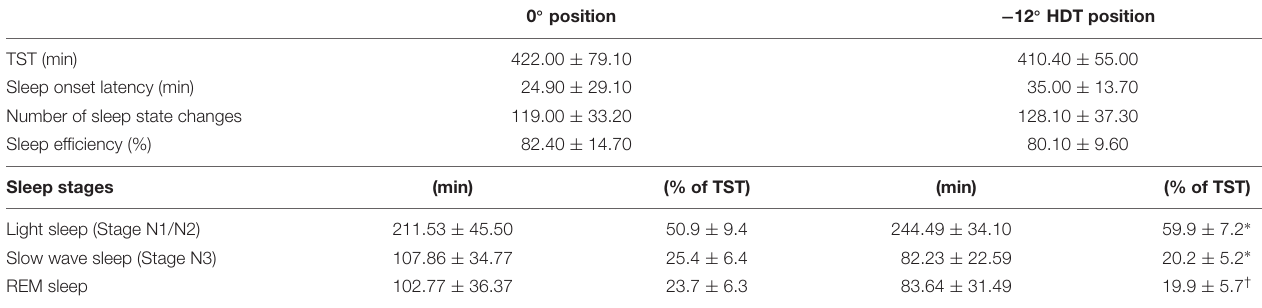
Table giving an overview of the objective sleep parameters at − 12 ◦ HDT and horizontal position. The values are given in means ± standard deviation. ∗ P = 0.002, † P = 0.035 in comparison to (% of TST) in 0 ◦ position. HDT, Head down tilt; TST, Total sleep time.